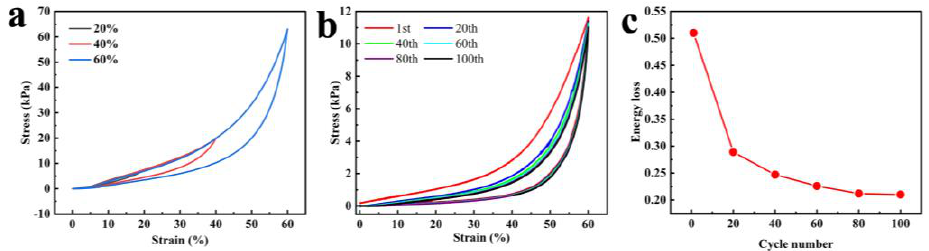
Figure 2. Mechanical compressibility and elasticity of the elastic wood. ( a ) Stress–strain curves of the elastic wood compressed at maximum stress of 20%, 40%, and 60%, respectively. ( b ) Stress–strain curves for the elastic wood under tangential compression for up to 100 cycles of loading and unloading. ( c ) Energy loss of the elastic in different cycles derived from the stress–strain curves in ( b ).